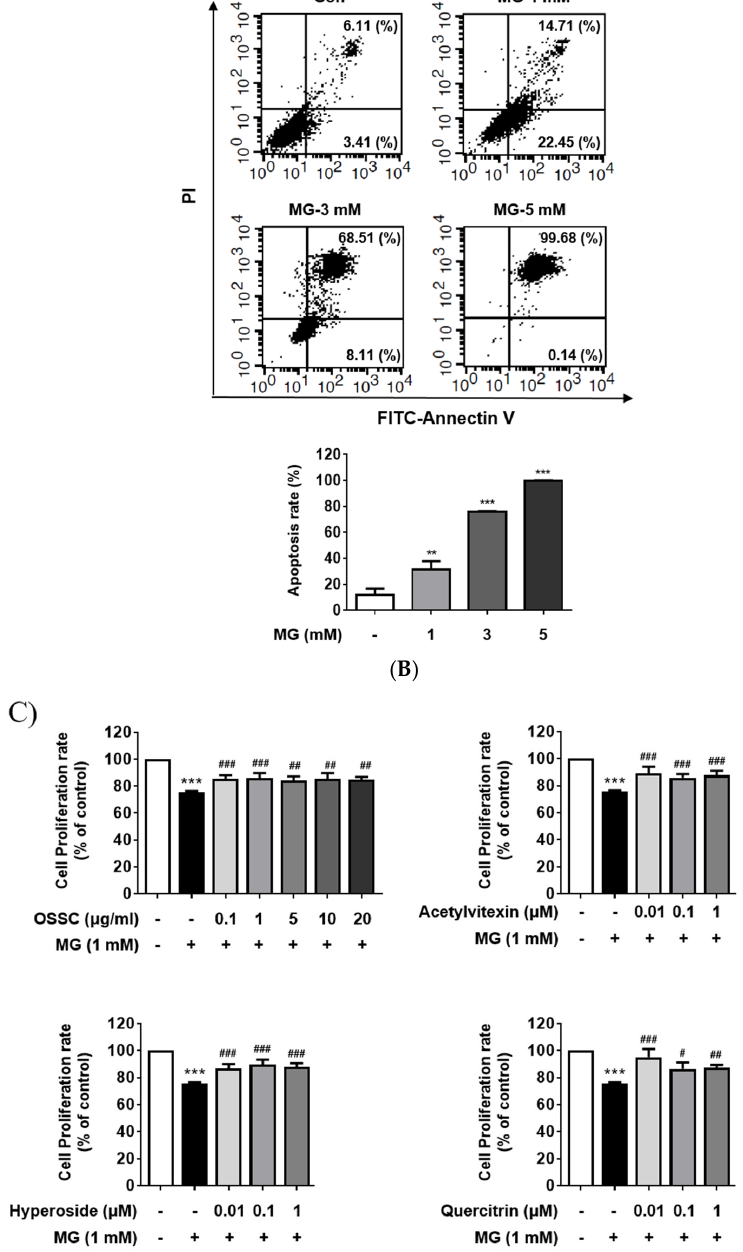
Figure 1. Effects of the Osteomeles schwerinae C. K. Schneid. (OSSC) extract and its major compounds on the viability of methylglyoxal (MG)-treated cells; ( A ) proliferation rates. Data are representative of three independent experiments and are expressed as the mean ± S.E.M. ( n = 4). *** P < 0.01 vs. control; ( B ) FACS analysis. *** P < 0.01, ** P < 0.05 vs. control, respectively; ( C ) proliferation rates after treatment with the OSSC extract (0.1 − 20 μ g/mL) and its major compounds (0.01–1 μ M). *** P < 0.001 vs. control; ### P < 0.001, ## P < 0.01, # P < 0.05 vs. MG,